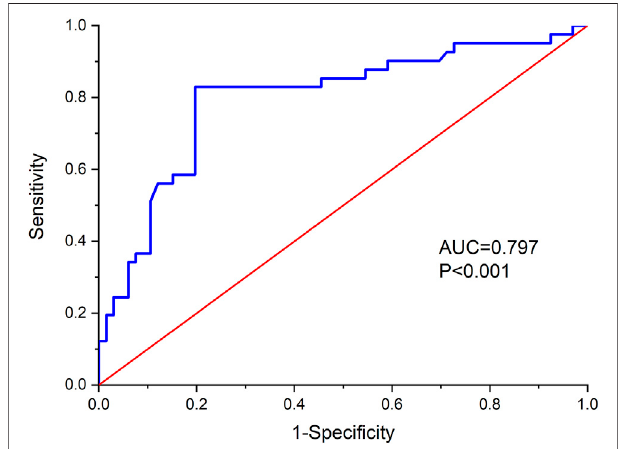
FIGURE 1 | Receiver operating characteristic (ROC)